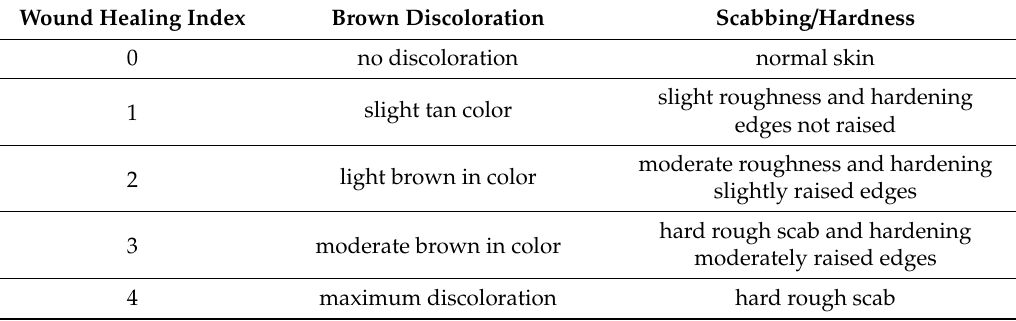
Table 1. Wound healing index of brown discoloration and scabbing / hardness. Wound Healing